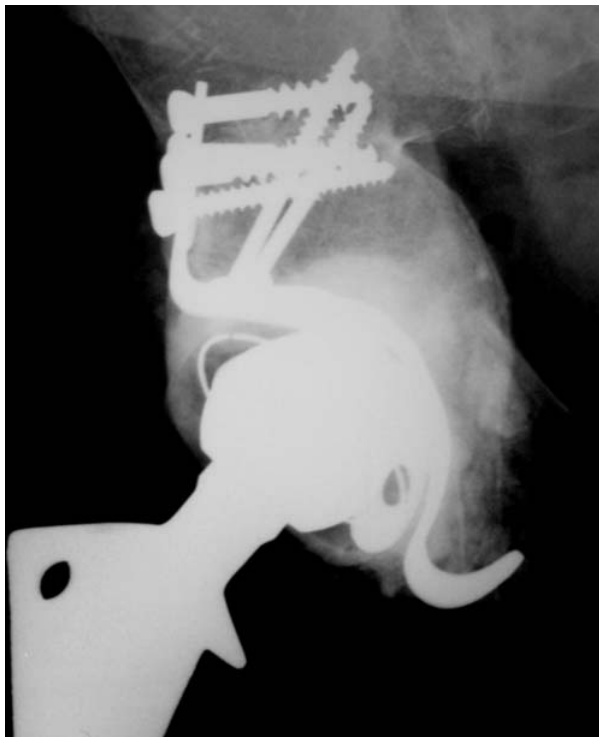
Figure 4 - Anteroposterior radiography of the reconstruction with lyophilized bovine graft and reinforcement device (three-year follow-up) showing sug- gestive signs of bone incorporation, as may be seen by the regularity of medium wall, graft density and absence of radiolucent